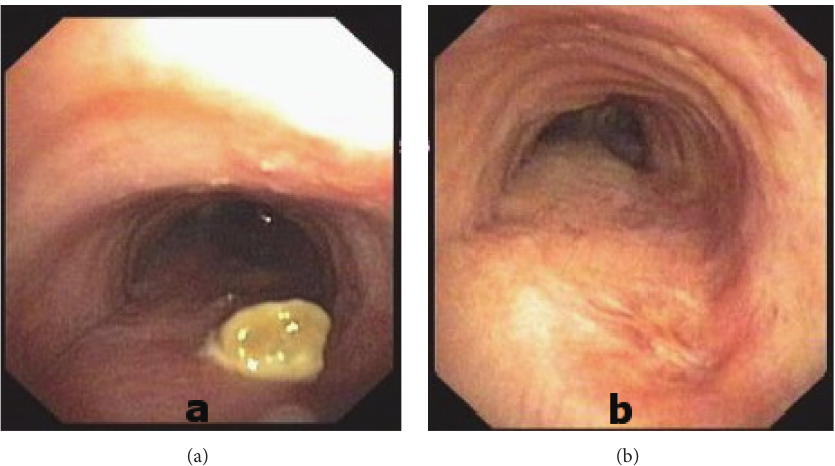
Figure 2: Bronchoscopic examination showed that the vegetating mass (a) is completely resolved after third month of treatment (b).